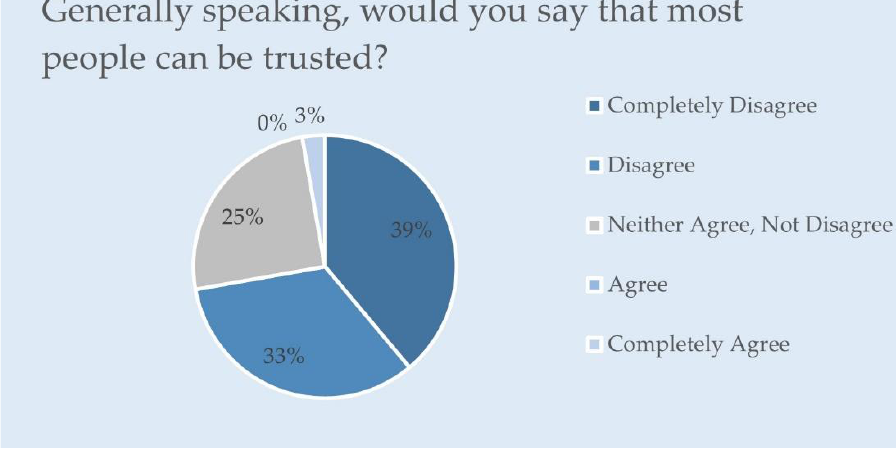
Figure 18. Distribution of responses from the survey. We combined the results of the trust games (TG) and public goods games (PGG) with complementary survey responses and designed a measure of social capital, consisting of five dimensions. We measured bonding social capital, bridging social capital, and linking